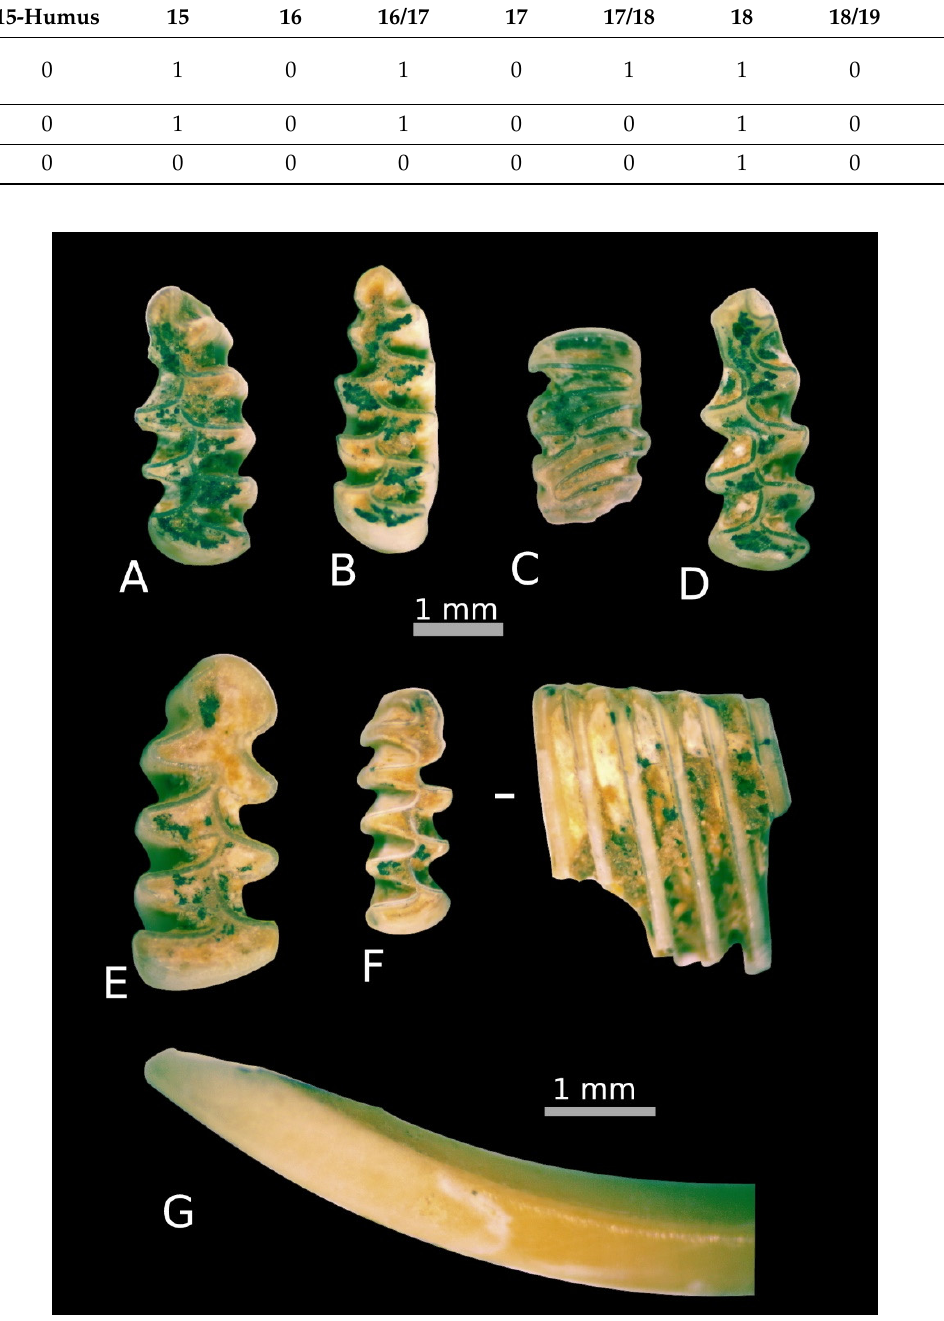
Figure 2. Rodent remains from La-Roche- à -Pierrot. ( A ) First lower molar (left) of Lasiopodomys gregalis ; ( B ) first lower molar (left) of Microtus arvalis / agrestis ; ( C ) third upper molar (right) of Lemmus / Myopus ; ( D ) first lower molar (left) of Microtus oeconomus ; ( E ) first lower molar (right) of Arvicola amphibius ; ( F ) first lower molar (right) of Lasiopodomys gregalis with signs of moderate digestion (category 2), occlusal and lateral view; ( G ) rodent lower incisor (left) with signs of light digestion (category 1), characterised by the reduction of enamel on the tip (Table